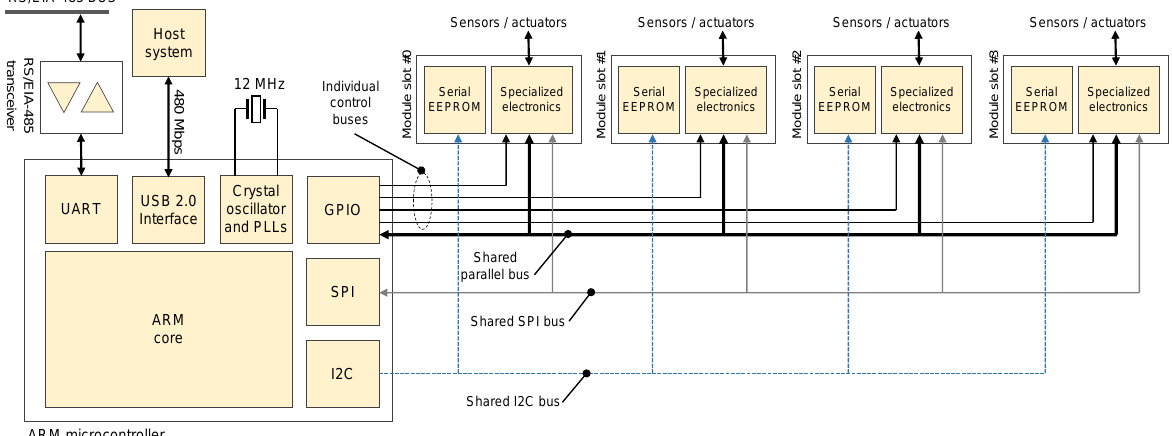
Figure 1. Simplified block diagram of our proposal DAQ platform. The